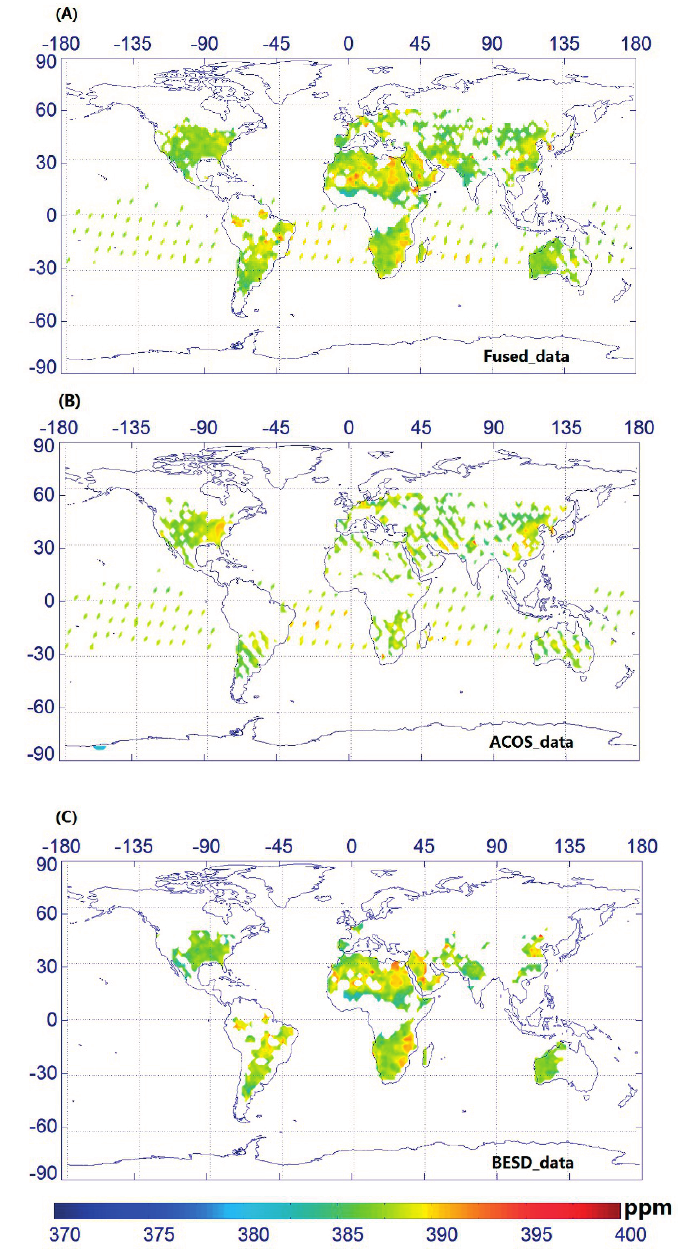
Figure 1. Spatial coverage of XCO monthly average in 2° × 2° bins: ( A ) Fused data for 2 October 2010; ( B ) ACOS data for October 2010; and ( C ) BESD data for October